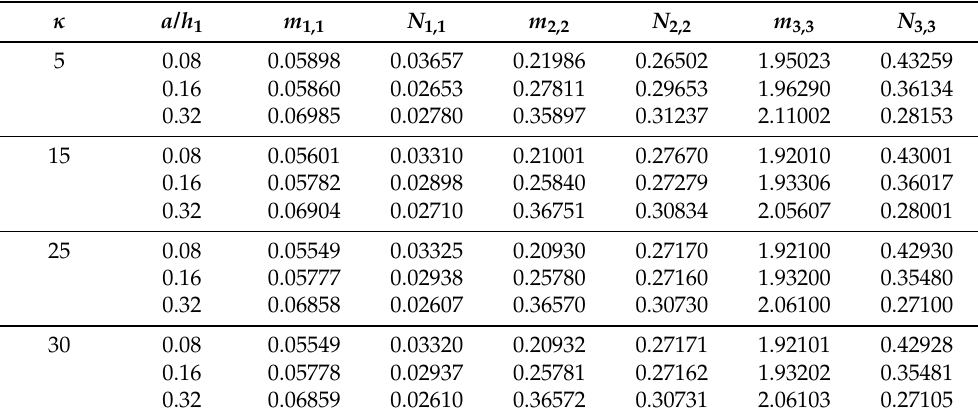
Table 1. Comparative study of m j , j and N j , j (for j = 1,2,3) for various values of a / h 1 with